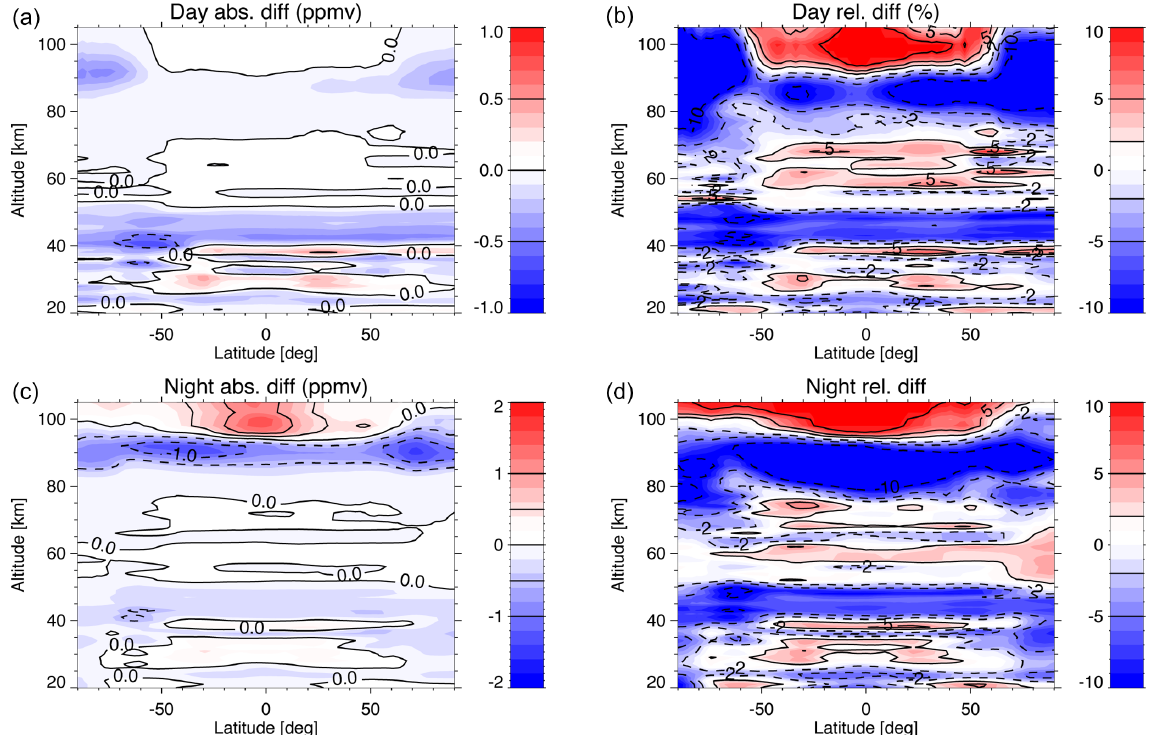
Figure 6. Comparison of O 3 abundance retrieved in the current V5r_O3_m22 with the previous V4O_O3_m02 version for daytime conditions (10:00) (a, b) and nighttime (c, d) . In absolute values (a, c) and in percent (b, d) of the older version